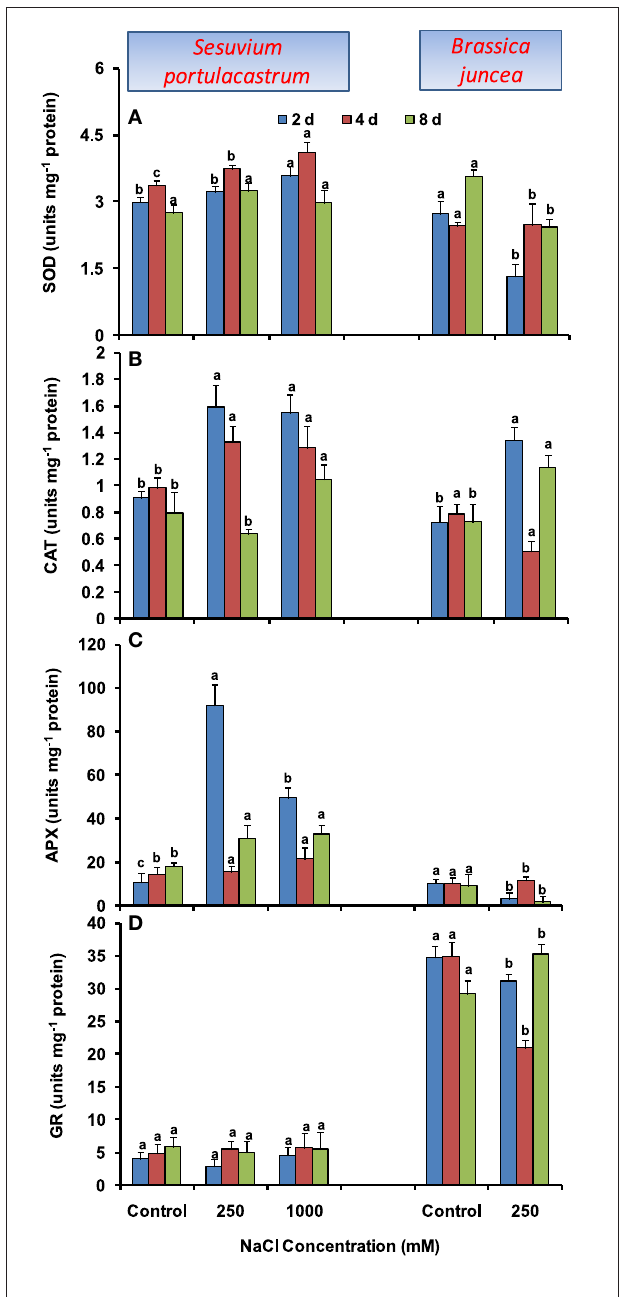
FIGURE 3 | Time dependent modulation of activities of superoxide dismutase (SOD; A), catalase (CAT; B), ascorbate peroxide (APX; C), and glutathione reductase (GR; D) in NaCl exposed Sesuvium portulacastrum and Brassica juncea . All values represent the mean of three replicates. Different letters indicate significantly different values at a particular duration (DMRT, P = 0 .01).